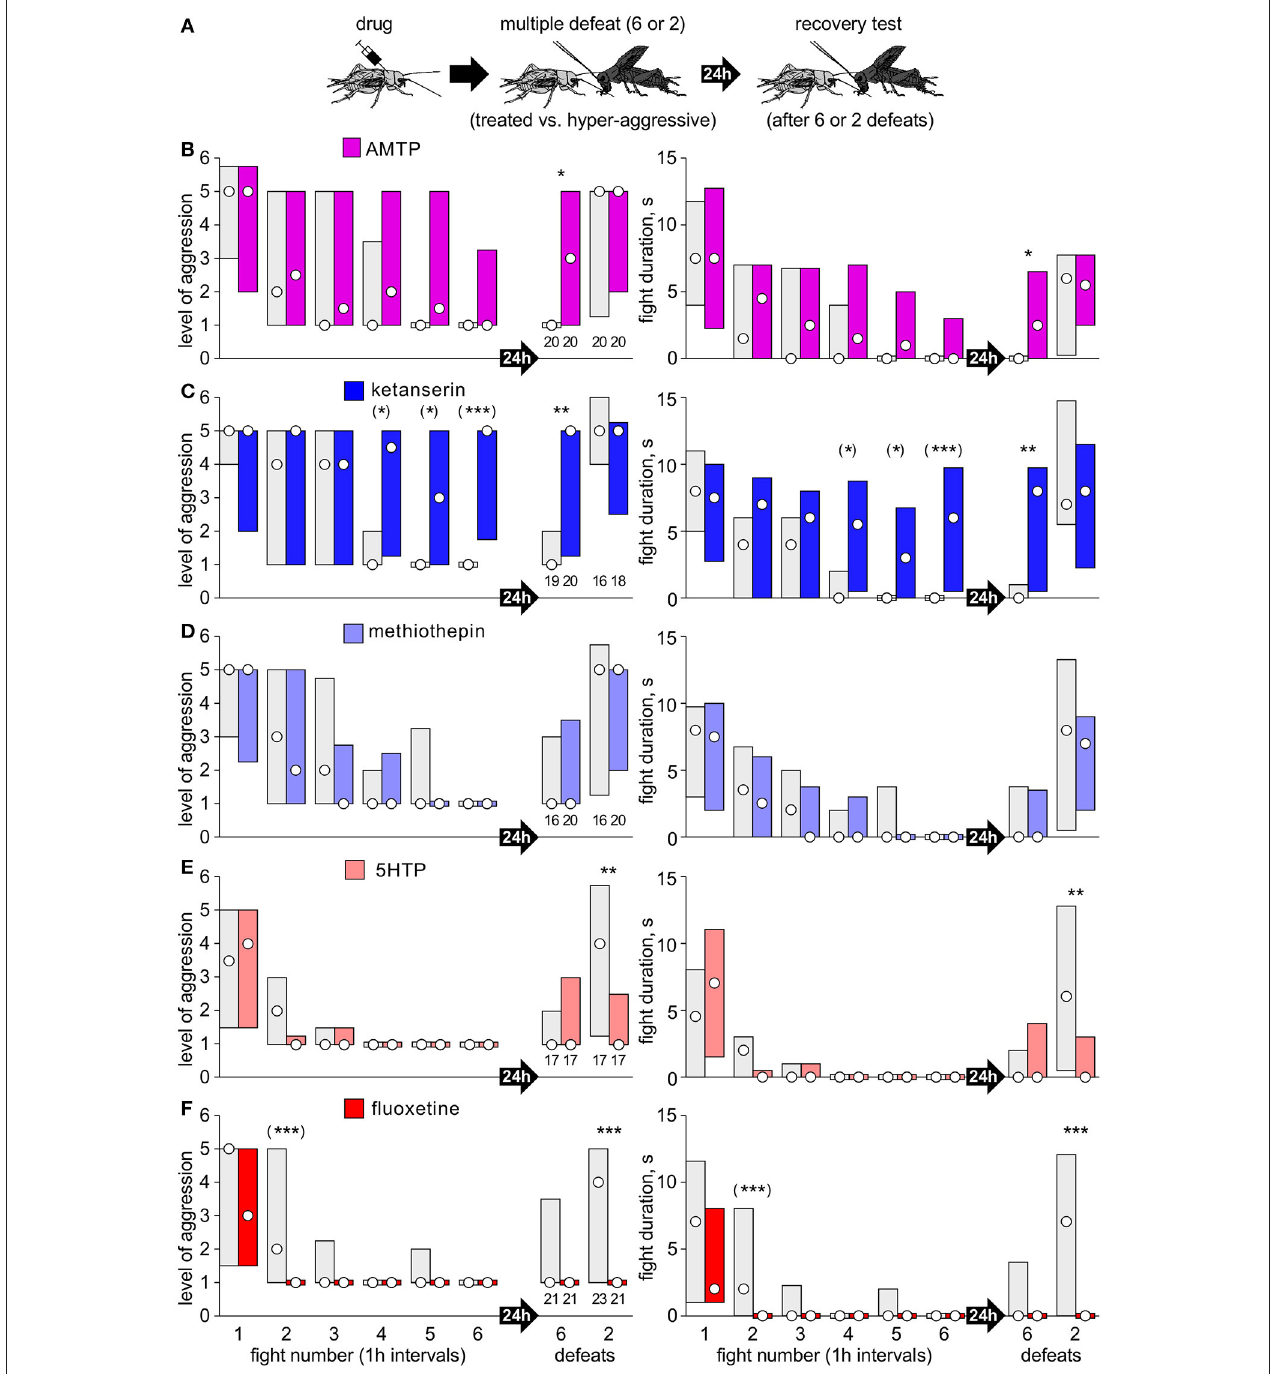
FIGURE 2 | Serotonergic drugs and chronic social defeat. (A) As in Figure 1 , except that separate cohorts of losers were rematched either 6 or 2 times in succession at 1h intervals and once more 24h later to check for long-term aggressive depression. (B–F) Bar charts giving the level of aggression (left) and fight duration (right, circle: median, bars: interquartile range, IQR; n is given above the left x-axis) for crickets that received: (B) AMTP (violet bars); (C) ketanserin (dark blue bars); (D) methiothepin (light blue bars); (E) 5HTP, (pink bars); (F) fluoxetine (red bars). Controls received vehicle (gray bars). Asterisks indicate significant differences between test and control groups as given by Mann-Whitney U-tests for the tests after 24h after defeat: *, **, ***: p < 0.05, 0.01, 0.001. For the six repeated defeats, we applied the Bonferroni corrections for multiple comparisons: (*), (**), (***): p < 0.01, 0.002, 0.0002).